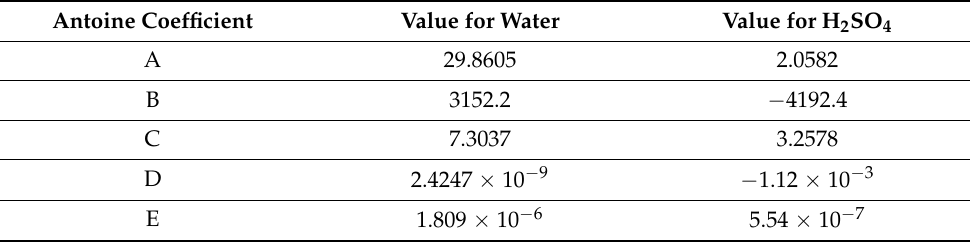
Table A1. Antoinine equation coefficients for the equation for the saturated vapour pressure over water and pure sulfuric